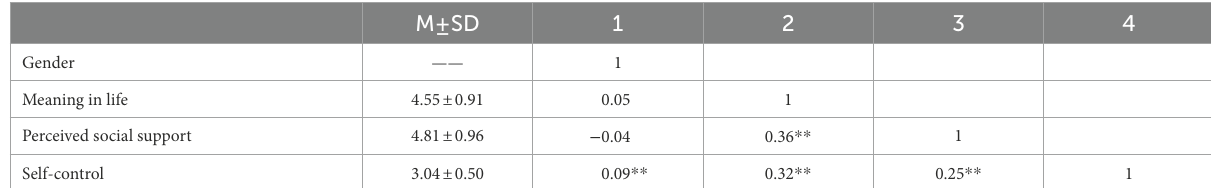
TABLE 1 Descriptive statistics and correlation analysis of the predictor